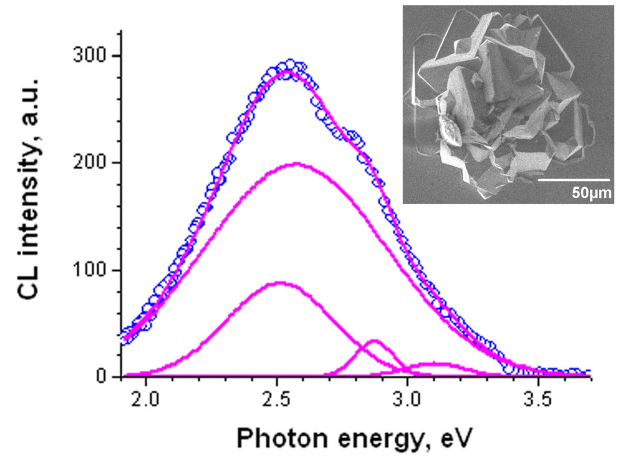
Figure 20. CL spectrum measured on the crystallite agglomerate (shown in the inset) with a beam energy of 10 keV (blue symbols). The emission bands and the resultant simulated spectrum are shown with magenta lines.